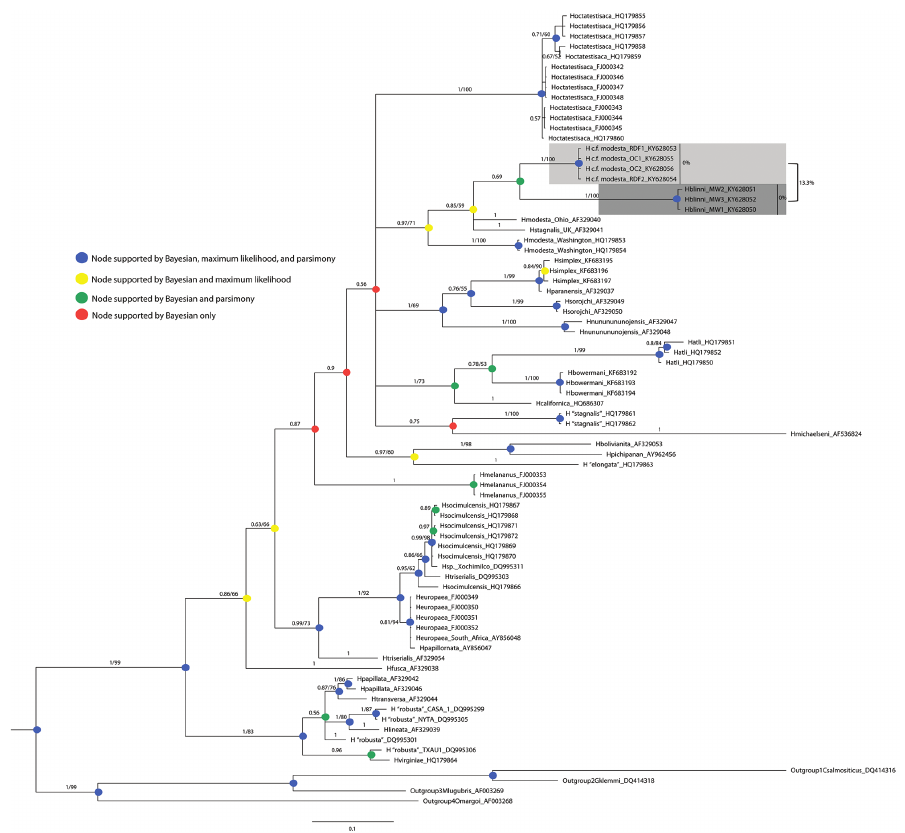
Figure 5. Bayesian Inference phylogenetic tree with 25% burn-in and support was assessed based on clade posterior probabilities tree. We included COI sequences from 31 species of Helobdella (family Glos- siphoniidae). The Arizona populations are from Oak Creek (OC), Rio de Flag (RDF), and Montezuma Well (MW). Our outgroup included Cystobranchus salmositicus (Meyer, 1946), Gonimosobdella klem- mi (Williams & Burreson, 2005), Myzobdella lugubris (Leidy, 1851), and Ozobranchus margoi (Davies, 1978). The shaded branches are the Arizona sample sequences. Branch labels include the Bayesian / ML probability. The blue nodes are supported by Bayesian Inference, Maximum-Likelihood, and parsimony analyses. The yellow nodes are supported by Bayesian Inference and Maximum-Likelihood analyses. The green nodes are supported by Bayesian Inference and parsimony analyses. The red nodes are supported by Bayesian Inference analysis